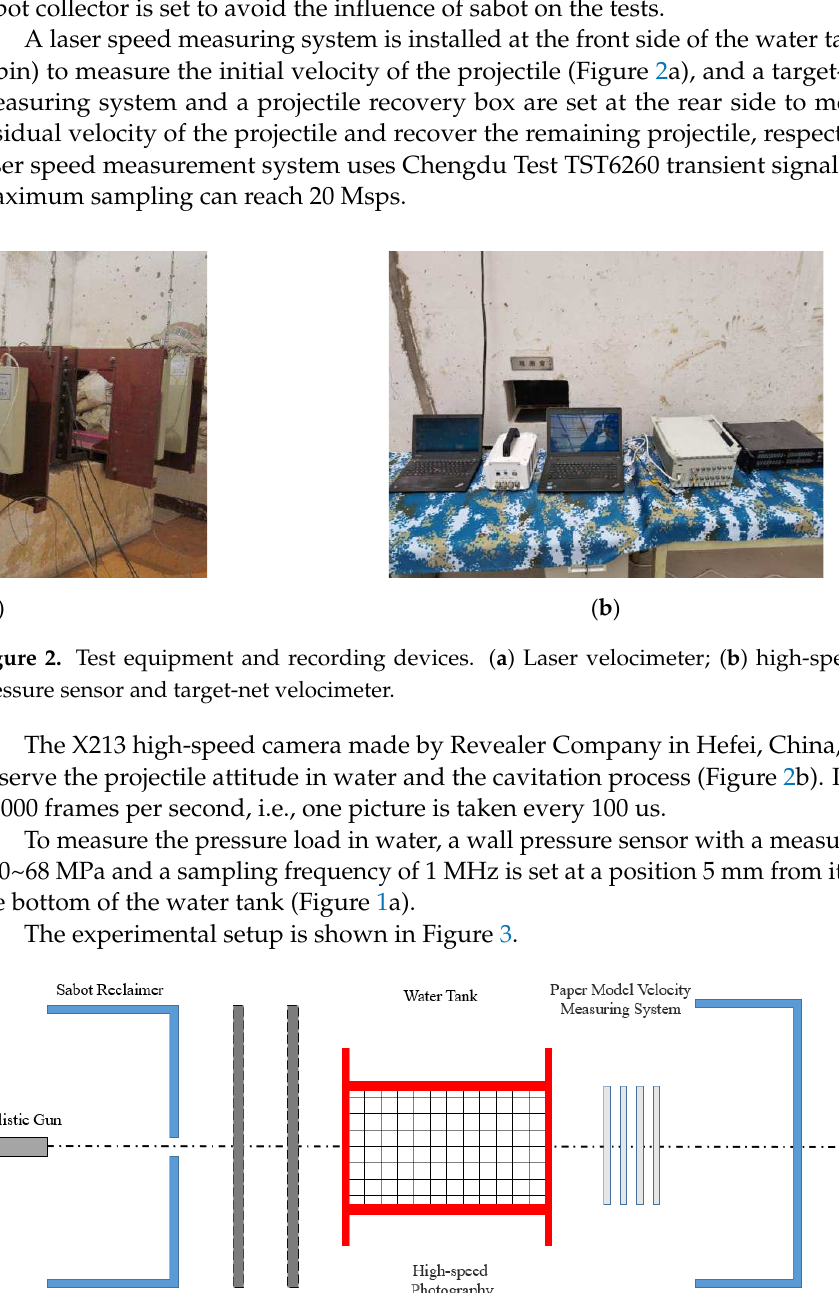
Figure 1. Diagram and photo of the water tank model. ( a ) Diagram of water tank model. ( b ) Water tank model.